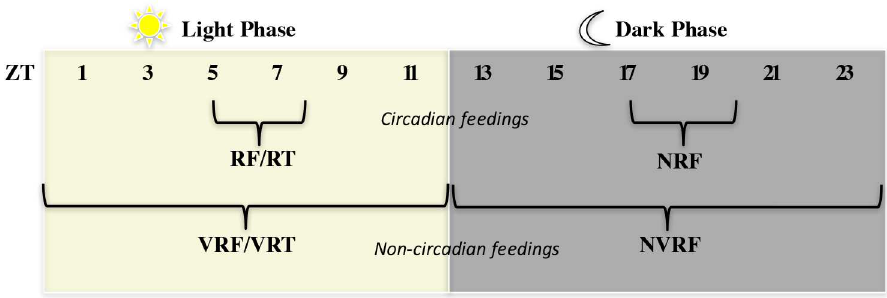
Fig 1. Schematic of daily feeding schedules. Circadianfeedingsoccurred daily duringa 2-3h feeding windowduringthe lights on phase(RF/RT) or lights off phase (NRF). Non-circadian feedings occurred daily duringa variable2h-feedingwindow, restricted to the lights on phase(VRF and VRT) or lights off phase (NVRF).